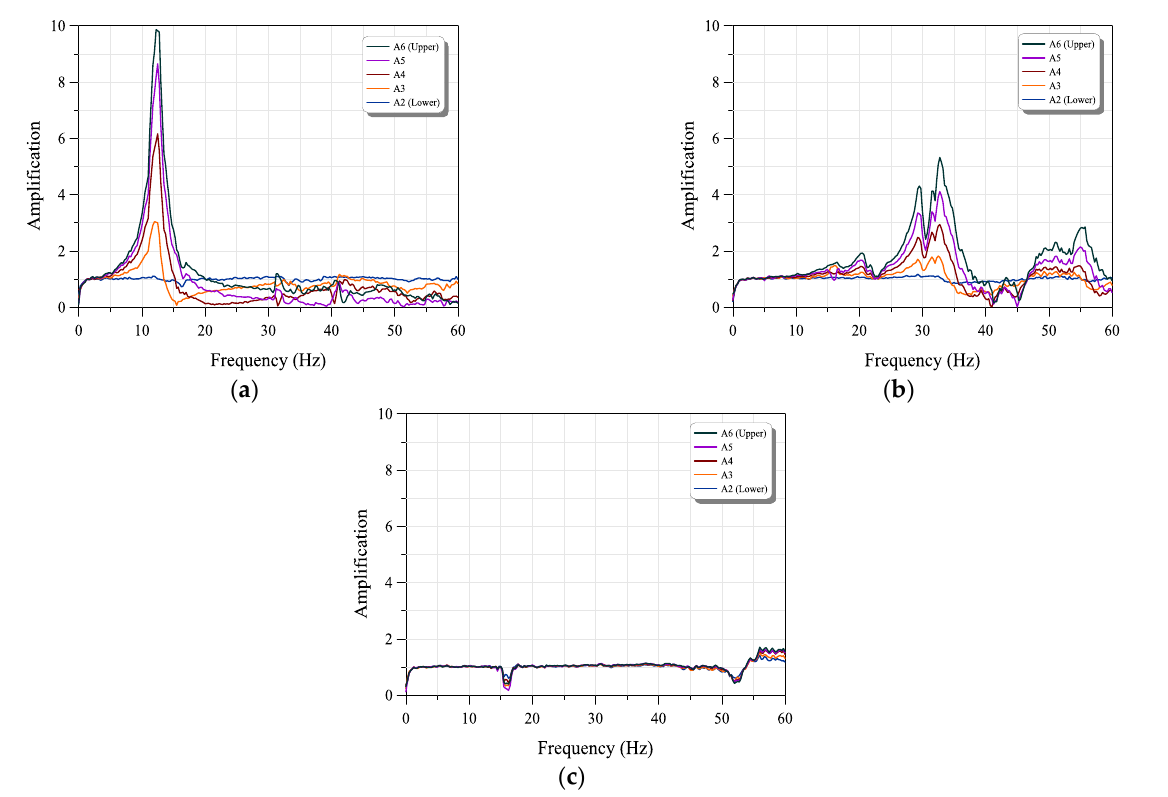
Figure 6. Out-cabinet resonant-frequency test results: ( a ) side to side, ( b ) front to back, and ( c ) vertical.